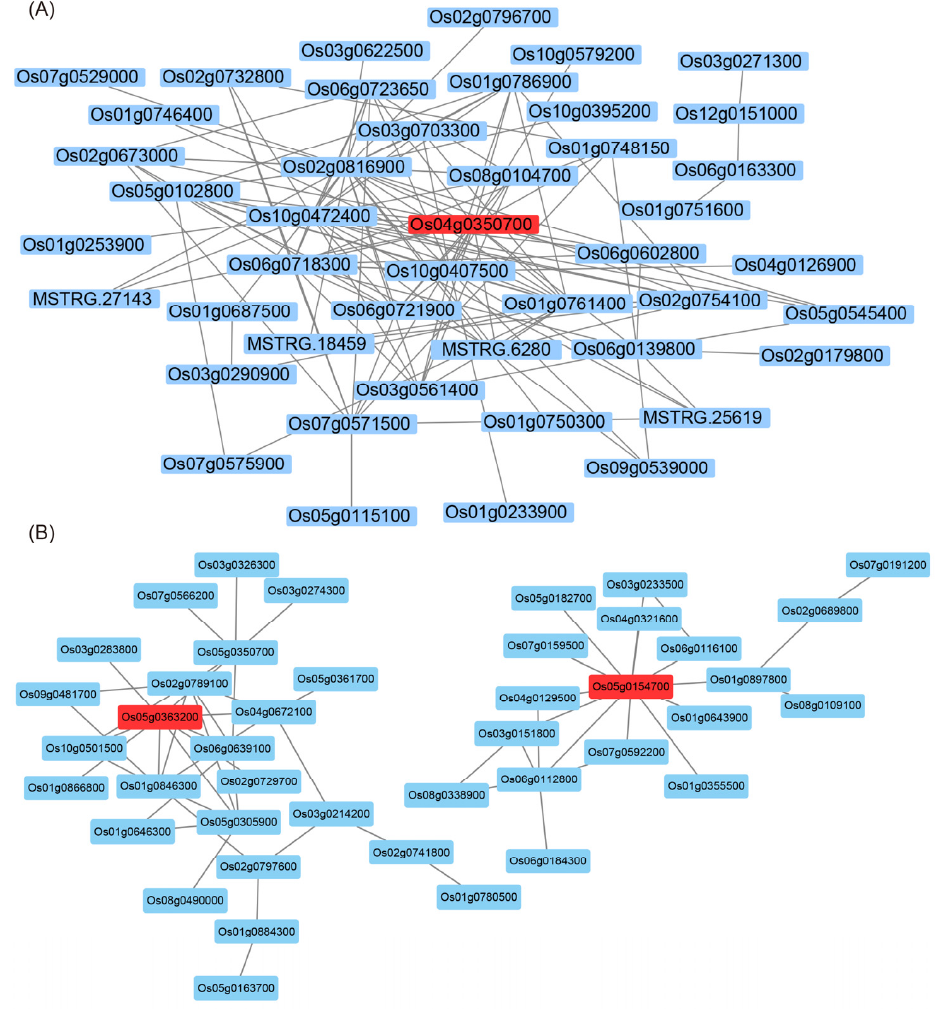
Figure 4. Gene coexpression networks within the honeydew1 ( A ) and grey60 ( B ) modules and their core genes. Table 3. Functional annotation of core genes in yield- and quality-related modules.